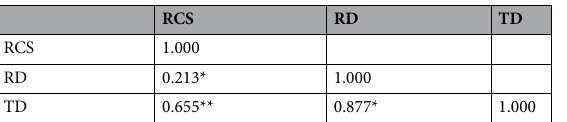
Table 5. Pearson correlation coefficients among levels of RD, RCS and TD. *Correlation is significant at the 0.05 level (two-tailed). **Correlation is significant at the 0.01 level